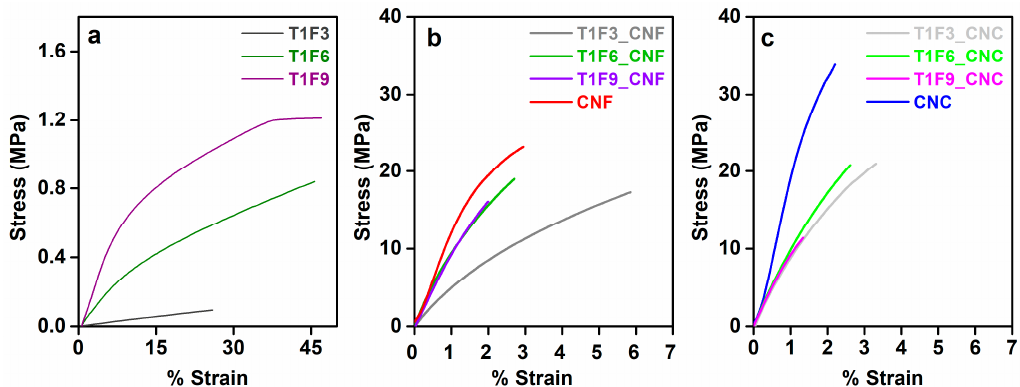
Figure 7. Stress-strain plots obtained from dynamic mechanical analysis. ( a ) Cured resins (T1F3, T1F6, and T1F9), ( b ) CNF-reinforced biocomposites (T1F3_CNF, T1F6_CNF, and T1F9_CNF), and ( c ) CNC-reinforced biocomposites (T1F3_CNC, T1F6_CNC, and T1F9_CNC). Table 2. Summary of mechanical and thermal properties of cured resins, as well as their CNF and CNC-reinforced biocomposites.